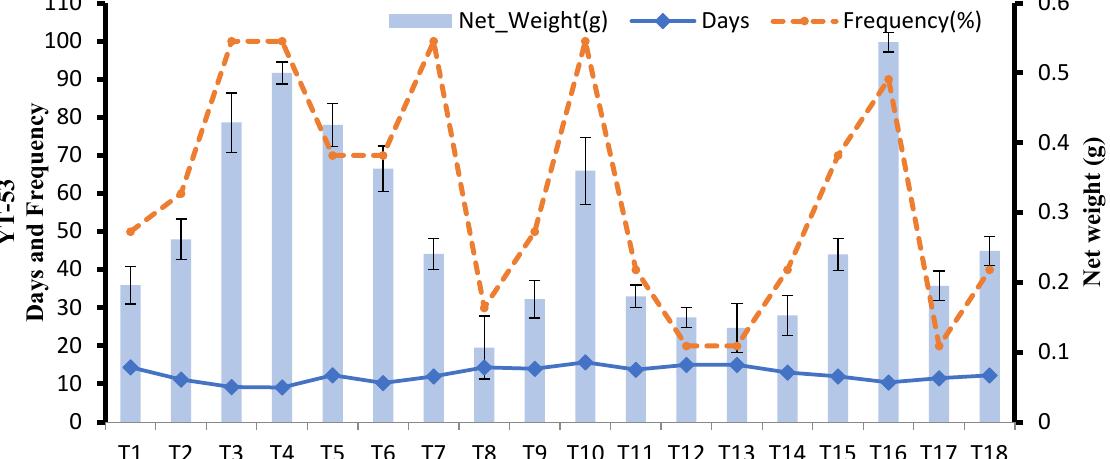
Figure 1. Effect of different media compositions on callus induction in terms of callus, number of days, and frequency in YT-53.